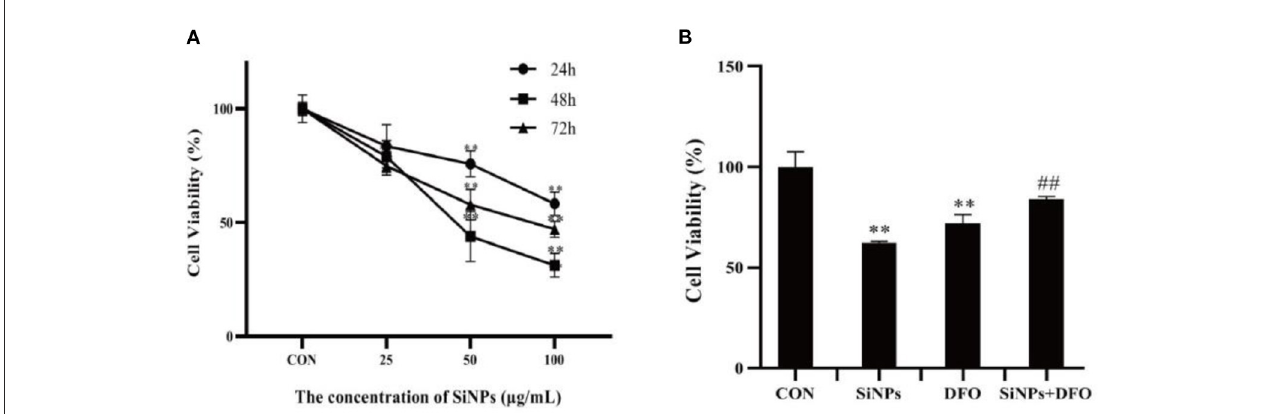
FIGURE1 The viabilities of HUVECs under SiNPs exposure. (A) The time- and dose-dependent viabilities of HUVECs exposed to SiNPs. (B) The DFO rescue the viabilities of HUVECs exposed to SINPs. [The negative control: con; * p < 0.05; ** p < 0.01, compared with the con; ## p < 0.01, compared with the SiNPs, n = 3].